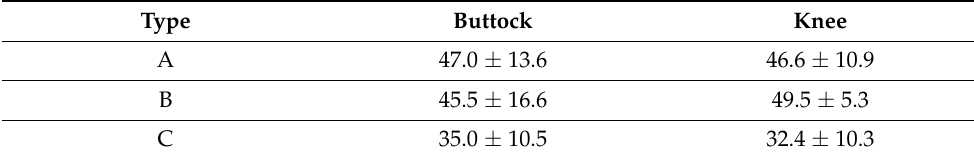
Table 3. Two-point discrimination threshold of type of